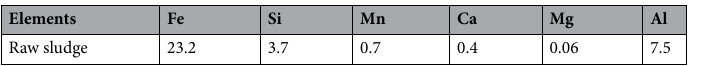
Table 1. Composition of the sludge before and after calcination (unit: